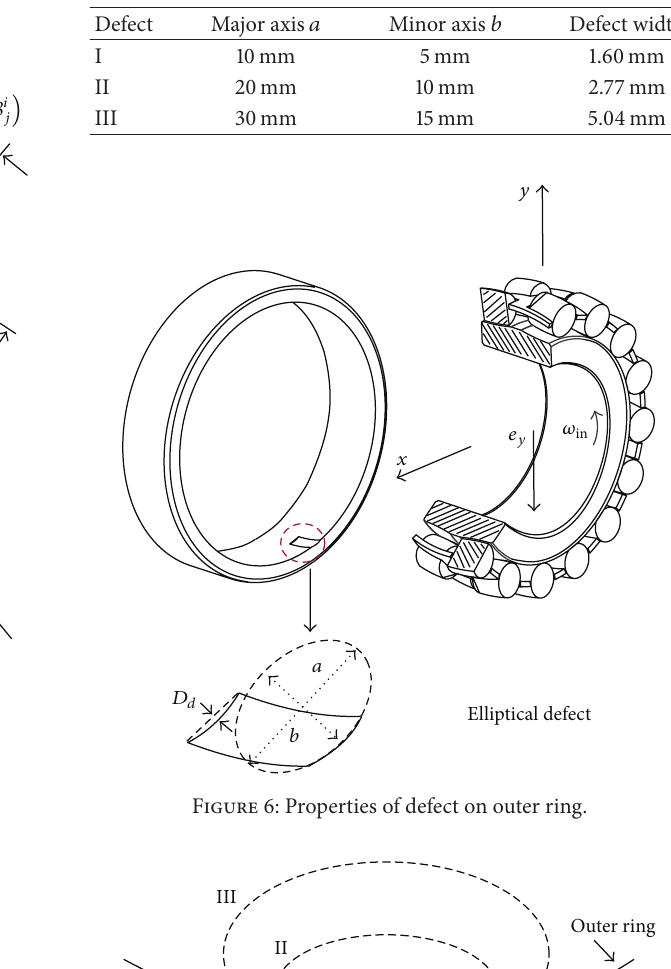
Table 2: Outer ring defects parameters.